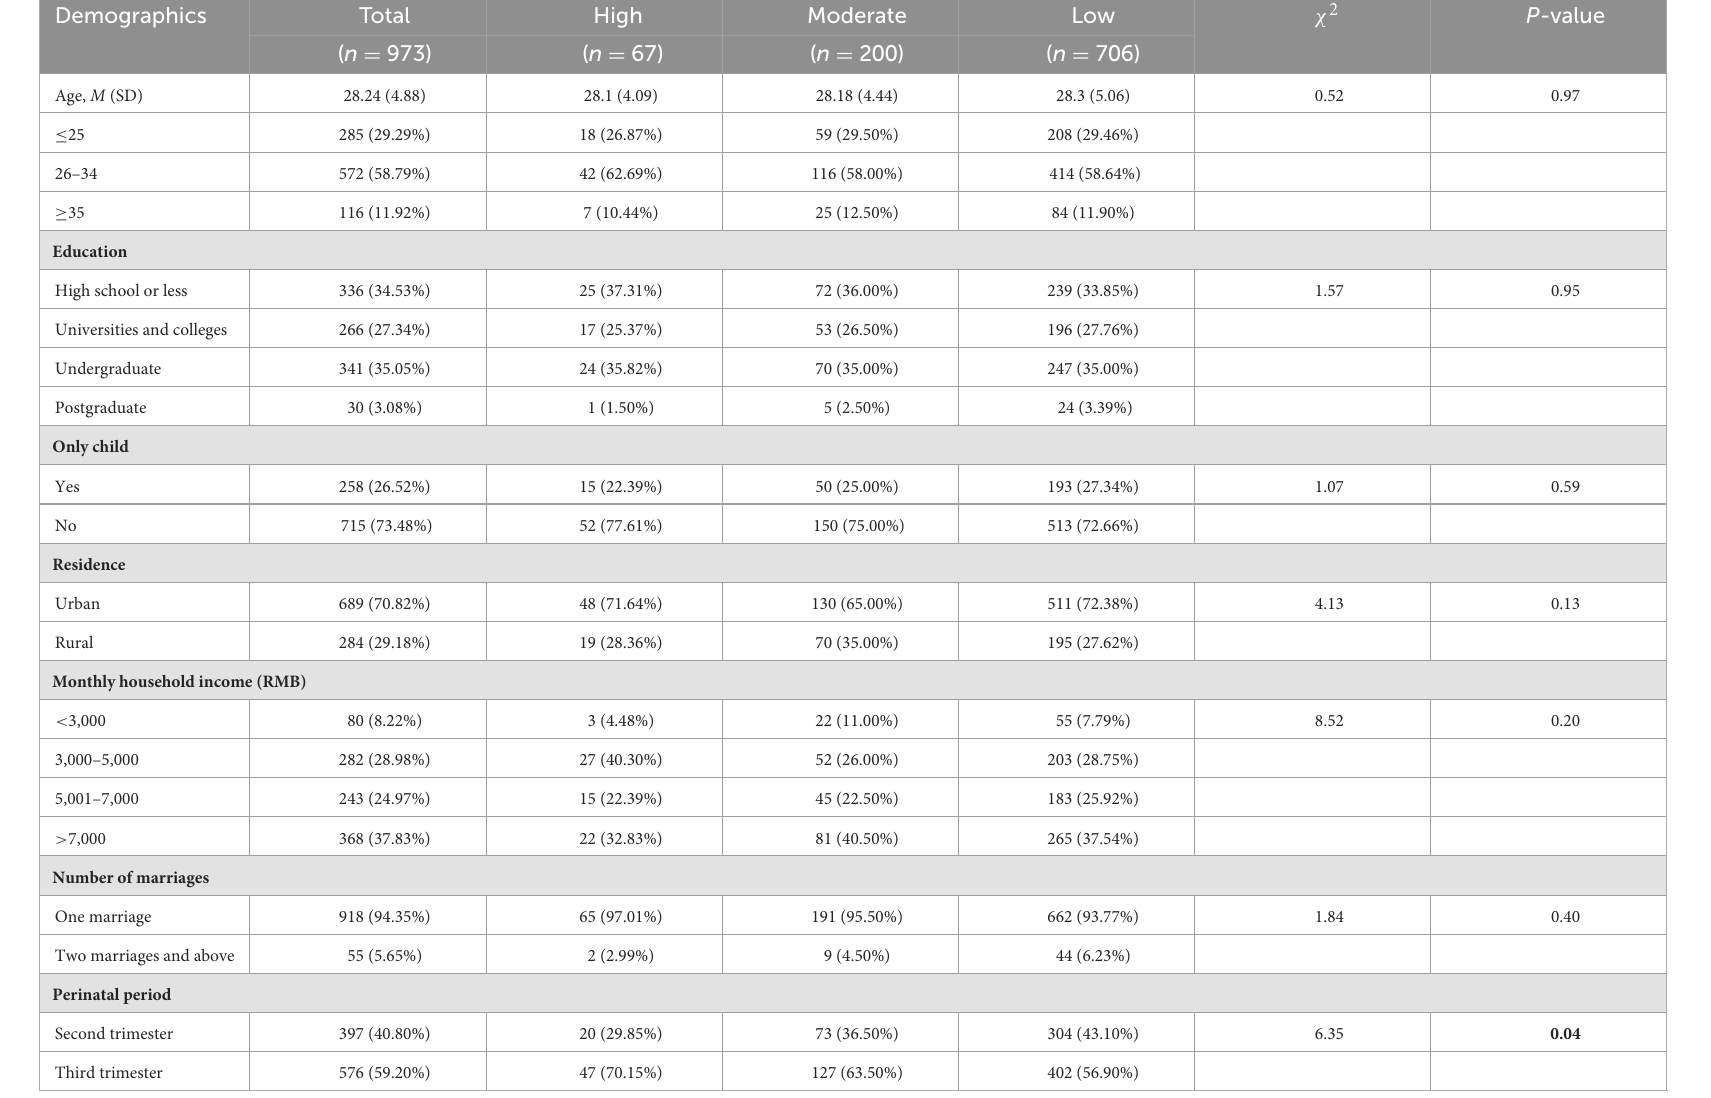
TABLE 2 Classification and comparison of three latent phenotypes of pregnant women with different demographic characteristics. Demographics Total